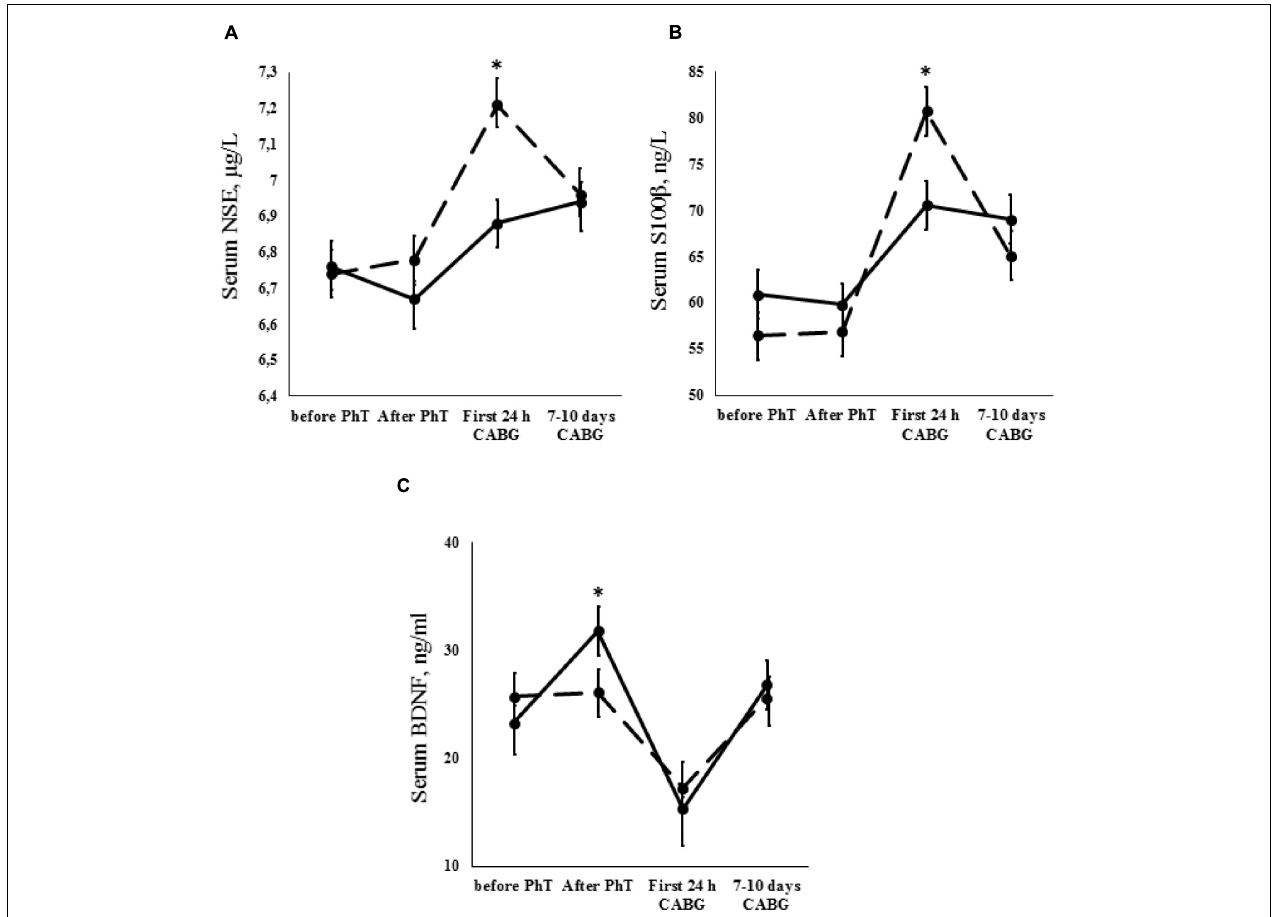
FIGURE 3 | Dynamics of neurovascular unit indicators [ A – neuron-specific enolase (NSE); B – S100 β protein; C – brain-derived neurotrophic factor (BDNF)] for the PhT group (continuous line) and the group who did not undergo PhT (broken line). Vertical bars denote standard error (SE). Asterisks ( ∗ ) indicate statistically significant differences ( p < 0.05) between two